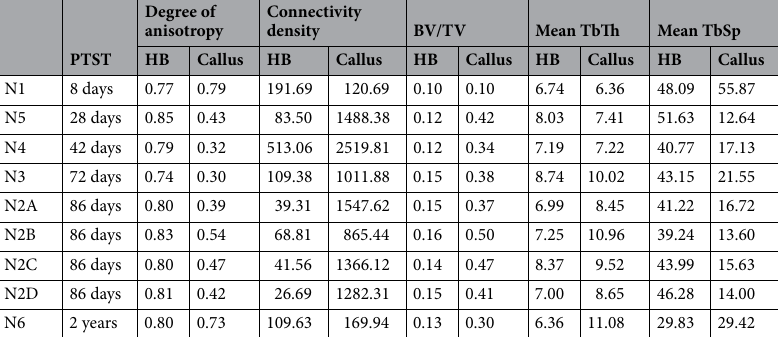
Table 1. Measurements of the histomorphometric parameters commonly used for the study of the 3D bone trabecular microarchitecture with micro-CT on nine fractures of known PTST. PTST post-traumatic survival time, HB healthy bone, BV/TV bone volume fraction, TbTh trabecular thickness, TbSp trabecular separation; REVs 1 and 4 of healthy bone and REVs 2 and 3 of callus area were